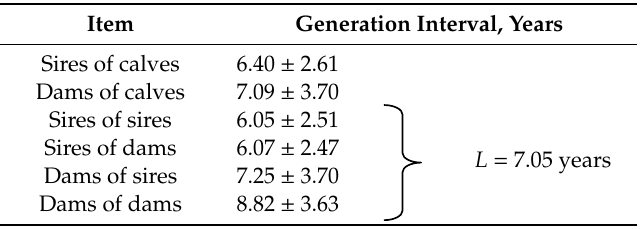
Figure 4. Age distribution of parents of calves in the whole population (calves born between 1978 and 2019).